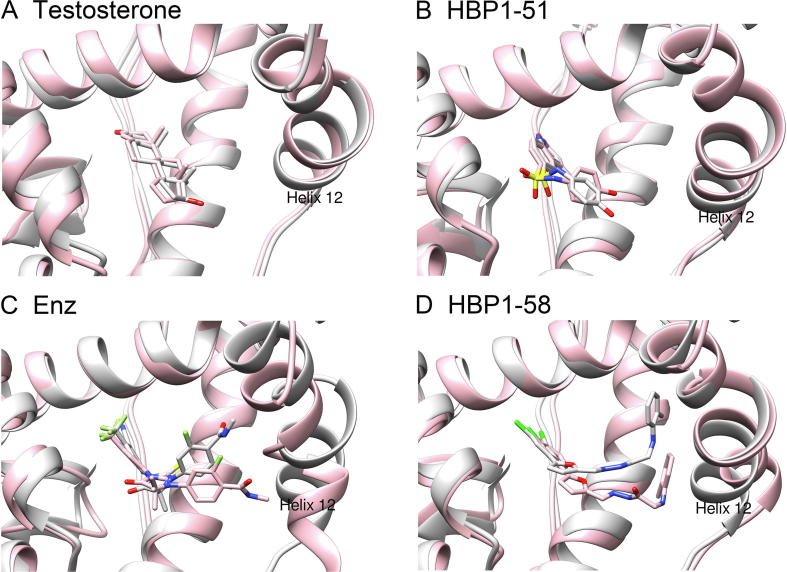
The agonistic and antagonistic state of AR-LBD complexed with the selected AR ligands revealed by MD simulationsShown are the conformational changes of helix 12 after 30 ns MD simulations for testosterone (A), HBP1-51 (B), Enz (C), and HBP1-58 (D). The initial structures of the receptor/ligand complexes were colored in light gray, and the conformations produced by the MD simulations were colored in pink.